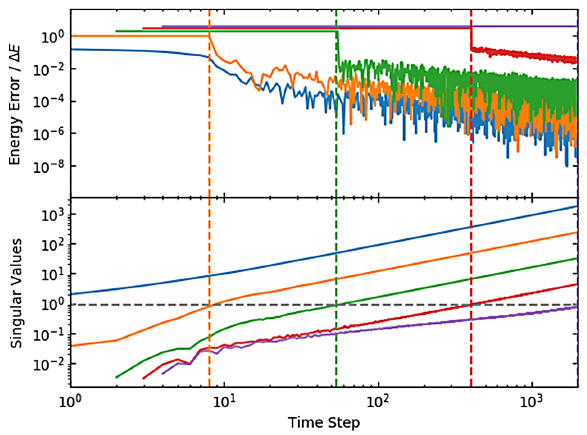
FIG. 3. Relative error and corresponding singular values of the overlap matrix for a Hamiltonian of linear spectrum for a large enough number of time steps to extract eigenstates below the error threshold. Upper panel: relative error of the first five eigenstates from the VQPE secular equation for a Hamiltonian of linear spectrum E N = N (cid:10) E ( (cid:10) E = 0.75 here) and perfect time step (cid:10) t P , including Gaussian noise N ( 0, 10 − 2 ) to the Hamilto- nian and overlap matrix elements. We choose the singular value truncation threshold s SV = 9 × 10 − 1 . The reference state follows (cid:11) (cid:3) ∝ | (cid:4) e − E N | N (cid:3) . Lower panel: corresponding singular val- 0 N ues of the overlap matrix as a function of time. The horizontal dashed line represents the singular value threshold s SV . The time step at which each singular value becomes larger than s SV is marked with a vertical dashed line, connecting upper and lower panels. See the text for